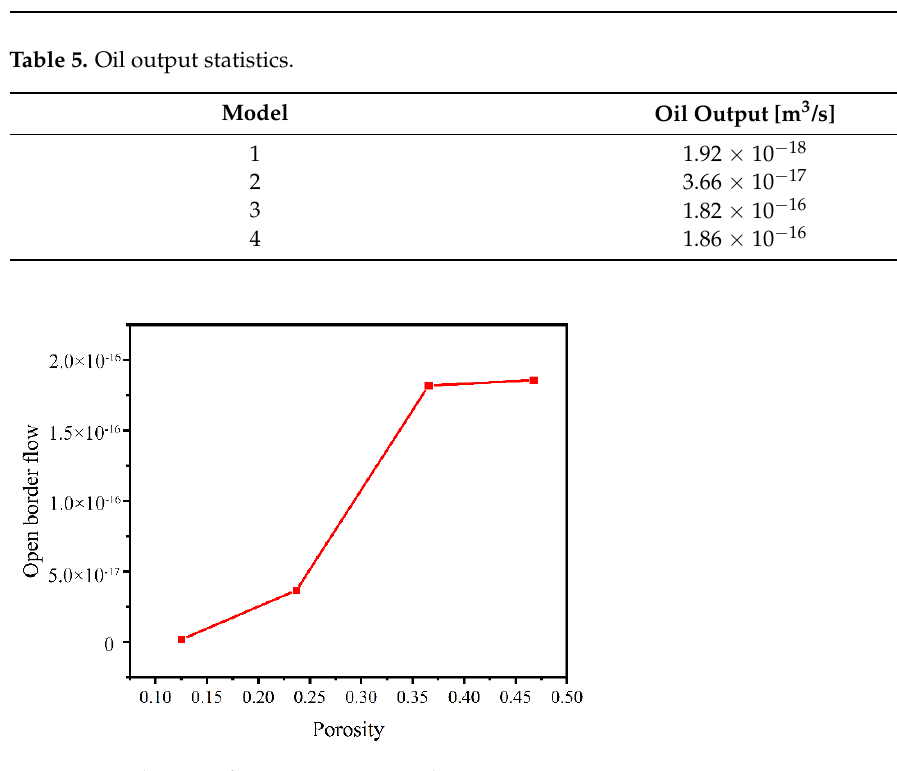
Figure 18. Oil output from porous materials.